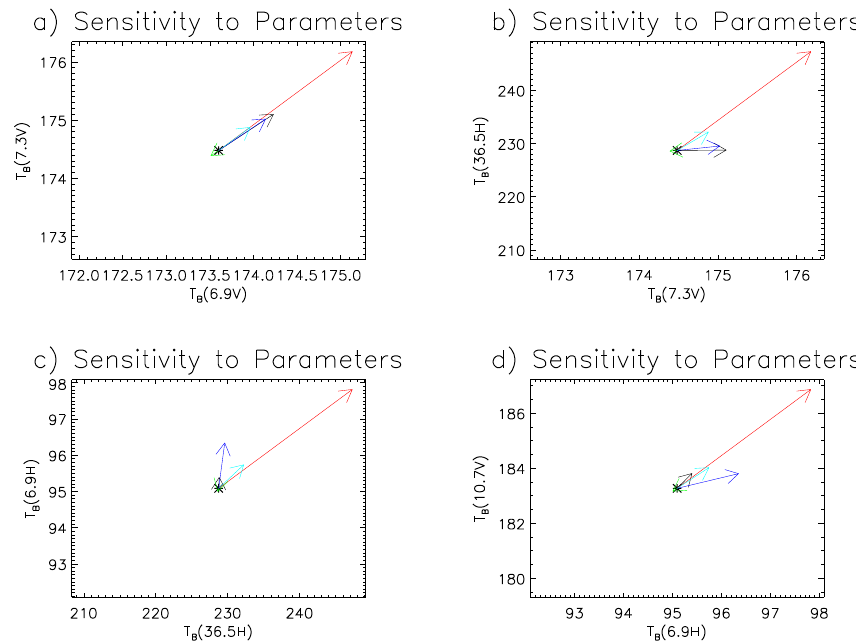
Figure 11. Sensitivity diagrams for an example atmospheric profile with high TCWV and TCLW (SST = 292 K, TCWV = 40.8 kg m − 2 , u = 2.7 m s − 1 , v = 14.8 m s − 1 , TCLW = 0.99 kg m − 2 ). Each arrow indicates, for two channels, the product of the brightness temperature sensitivity to a variable and the a priori uncertainty in that variable i.e., each arrow shows ∂ y ∂ x i σ i for the channels in y indicated on the figure axes. This is a measure of the magnitude of the response of the observations to the range of uncertainty in each retrieved variable. The variables are SST (black), ln(TCWV) (red), u (green), v (blue) and ln(TCLW) (cyan). The pairs of channels in each diagram are ordered ( a – d ) in accordance with the information content analysis for a five-variable retrieval vector in Table 1.